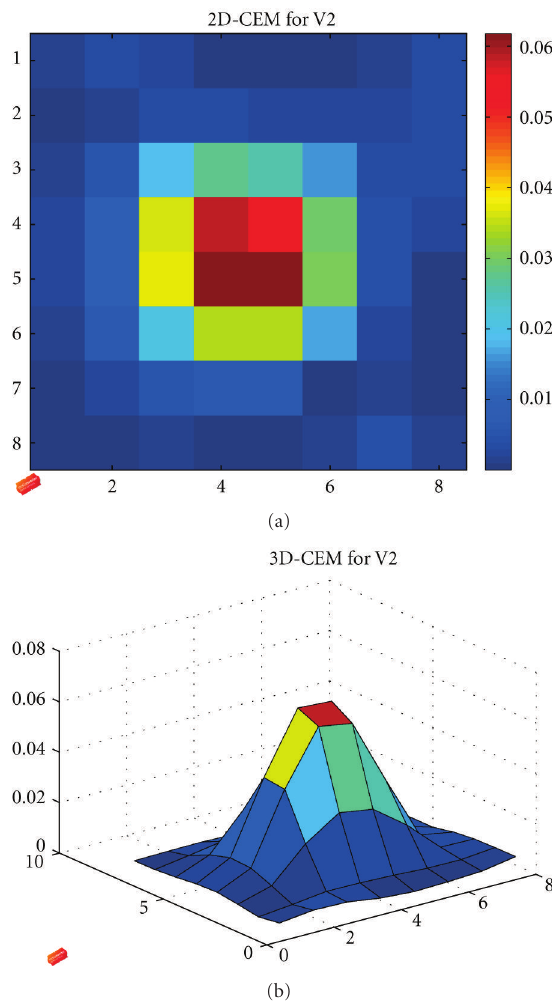
Figure 6: CEM results (2D and 3D) for target with pixel